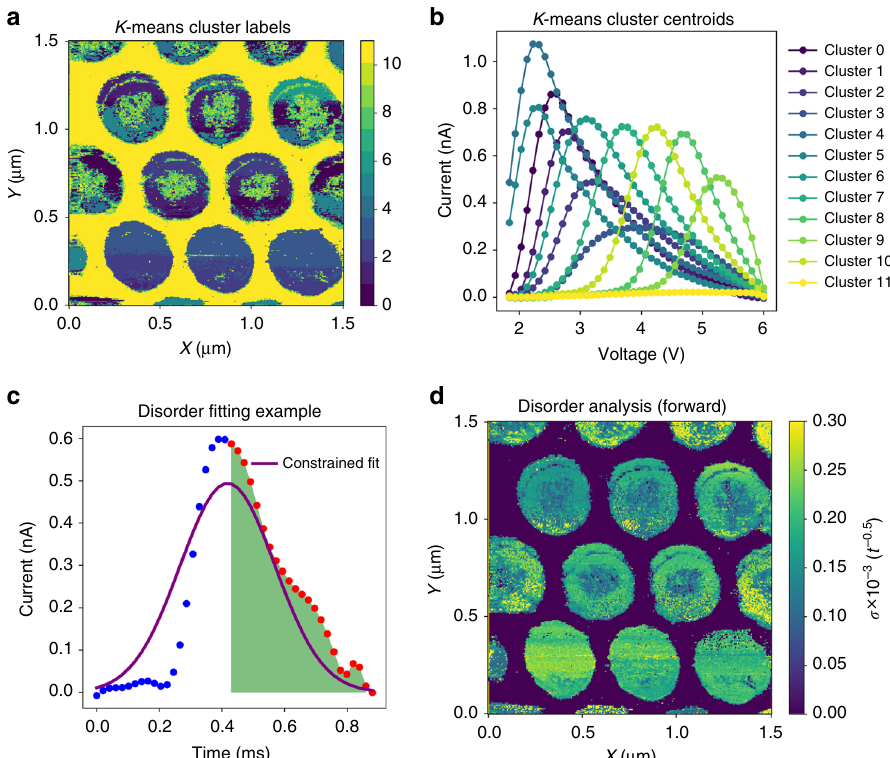
Fig. 7 Disorder analysis from switching traces. To investigate the variability of the switching current pro fi les, we performed K -means analysis with 12 clusters, restricting the data to the switching current traces in the positive voltage window. The result of the K -means analysis is shown in the cluster label map in a , and the mean response of each cluster in b . Note that clusters with < 20 members are not plotted on this graph. To obtain a more quantitative estimate on the disorder, a Gaussian fi tting procedure was applied to each switching current pro fi le. An example of the data is shown in Fig. 5. c after conversion from voltage to time axis. The procedure involves fi nding the time at which the integral of the area under the curve is half of the total area under the curve, and fi tting to only points at and beyond this time. Such points are indicated as red fi lled circles in the graph. A Gaussian fi t is then performed on these points, with the constraint that the area of the Gaussian be equal to the area of the whole switching curve (to normalize for the polarization). The extracted map of the variance is plotted in d , and clearly shows substantial variability from one nanocapacitor to